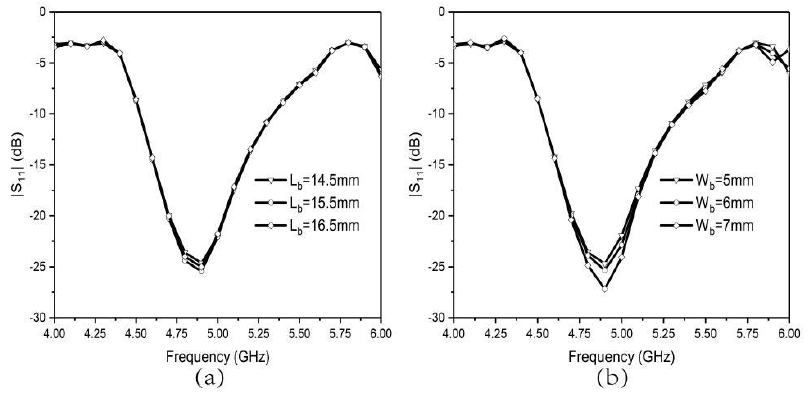
Figure 10. Simulated | S 11 | of the proposed array antenna with varying bow-tie radiator size parameters. ( a ) | S 11 | varies with L b . ( b ) | S 11 | varies with W b